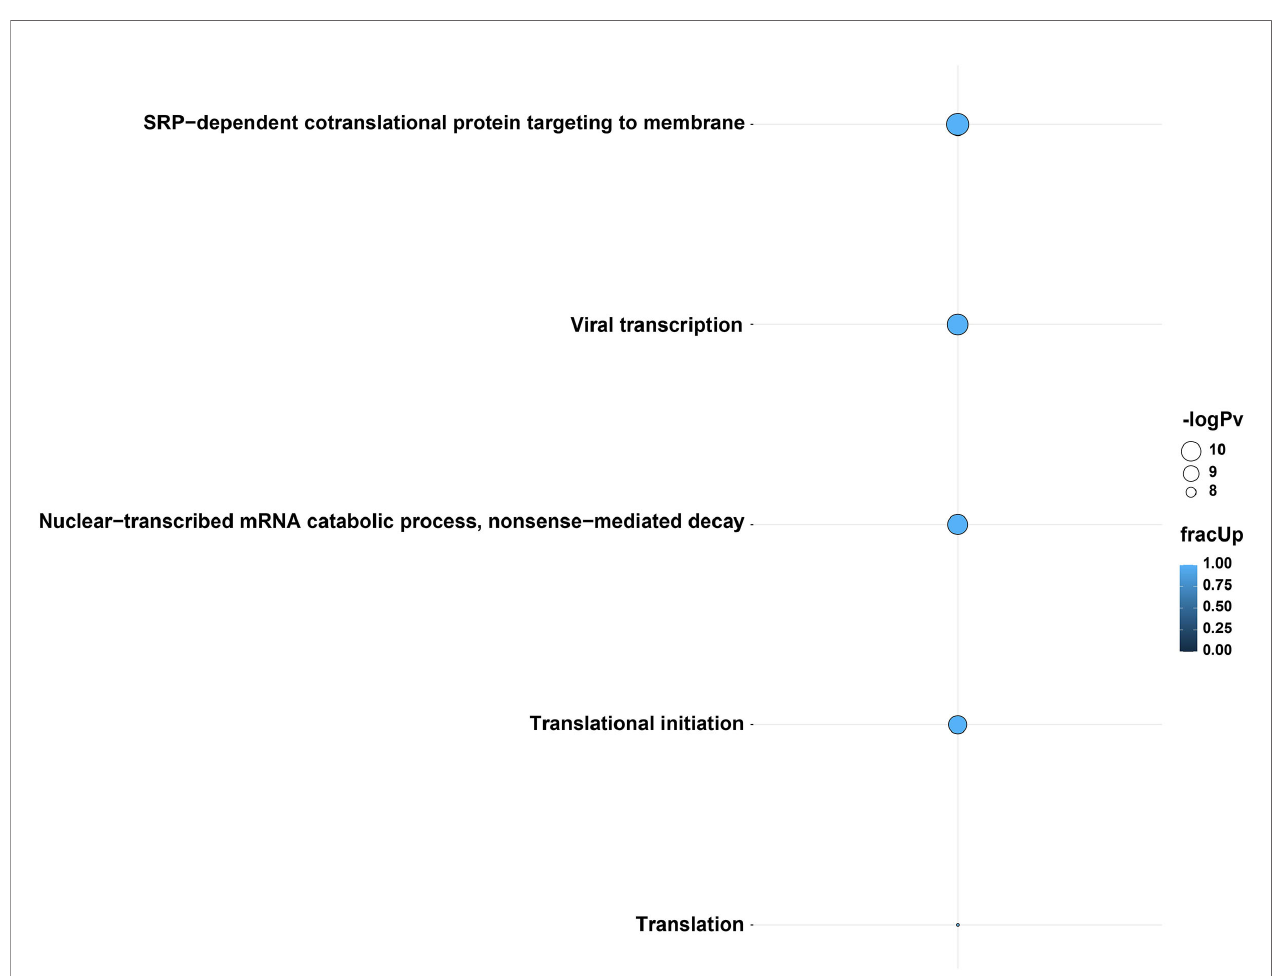
FIGURE 4 | GO biological terms from genes with differential poly(A) tail length in tail fi ndr poly(T) mixed-model analyses from the Calu-3 48 hpi direct cDNA dataset. Genes involved in viral transcription, translation, translational initiation, SRP-mediated cotranslational protein targeting to membrane and nuclear-transcribed mRNA catabolic process and nonsense-mediated decay pathways were increased in poly(A) tail length after infection. The enrichment of these GO terms suggests the importance of transcription, translation and protein pathways during SARS-CoV-2 infection. The bubble size and color indicate the -log10 enrichment p-values and the fraction of genes with increased polyadenylation, respectively. Thresholds of padj < 0.05, enrichment p-value < 0.0001 were used. Only bubbles which meet the thresholds are shown. Related to Figures S5, S6 and Data S3